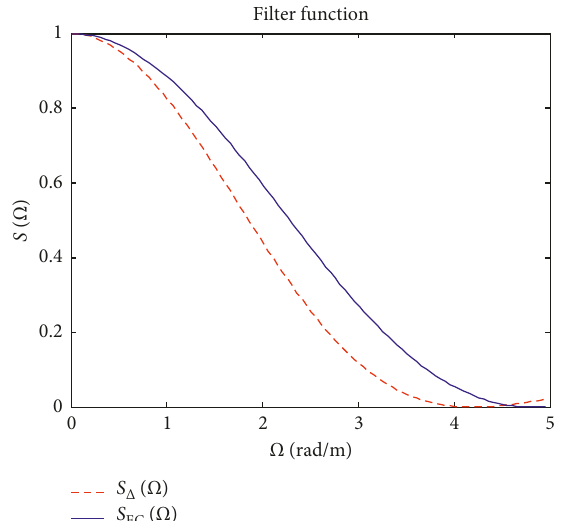
Figure 3: Low-pass filter for load spreading